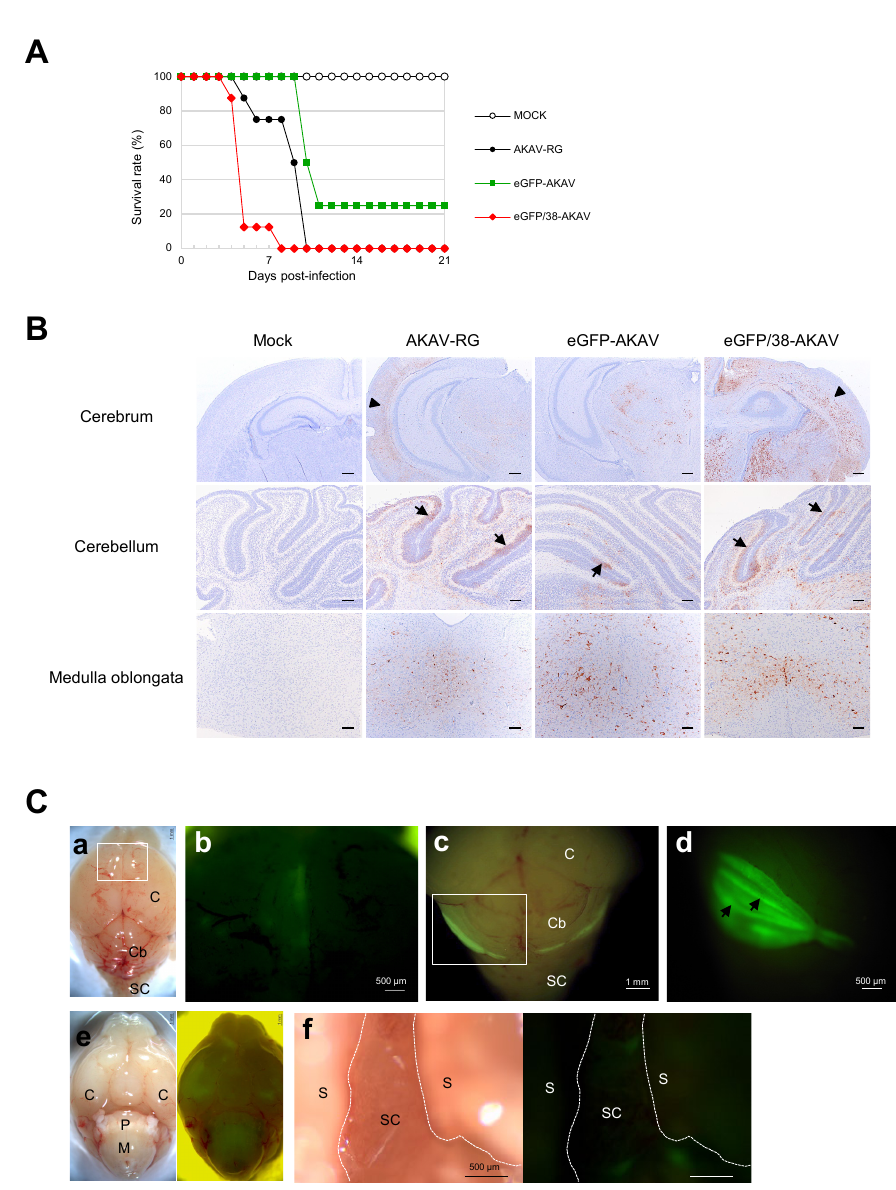
Figure 5. Experimental infection of mice with recombinant viruses. Suckling mice were intraperitoneally infected with AKAV-RG, eGFP-AKAV, or eGFP / 38-AKAV, or mock-infected and monitored for 3 weeks. ( A ) Survival curves of mice after infection with 1 × 10 5 PFU of each virus are shown. ( B ) Para ffi n sections of the central nervous system (CNS) tissues, such as cerebrum, cerebellum, and brainstem, including medulla oblongata, from each virus or mock-infected mice were immunostained for AKAV antigens using anti-AKAV polyclonal antibody. Viral antigens are shown in brown. The arrowheads in the cerebrum indicate virus-infected neurons in the cerebral cortex. The arrows in the cerebellum indicate virus-infected cells inside of the external granular layer in the cerebellum, corresponding to a cerebellar fissure anatomically. Bar, 100 µ m. ( C ) Macroscopic fluorescence in the CNS of mice infected with eGFP / 38-AKAV is shown. Viral infection was detected in the cerebrum ( a and b , 7 dpi), cerebellum ( c and d , 5 dpi), brainstem ( e , 8 dpi), and lumbar spinal cord ( f , 8 dpi). ( b ) Higher magnification of the box area in panel ( a ) light field is shown. Panel ( d ) is the caudal aspect of the cerebellum, indicated by a square in panel ( c ) at higher magnification. Intensive infection of eGFP / 38-AKAV was detected in the cerebellum, in particular cerebellar fissure, as indicated by arrows. ( e ) Light field (left) and eGFP (right) images of bottom aspect are shown. C, cerebrum; Cb, cerebellum; P, pons; M, medulla oblongata; S, spine; SC, spinal